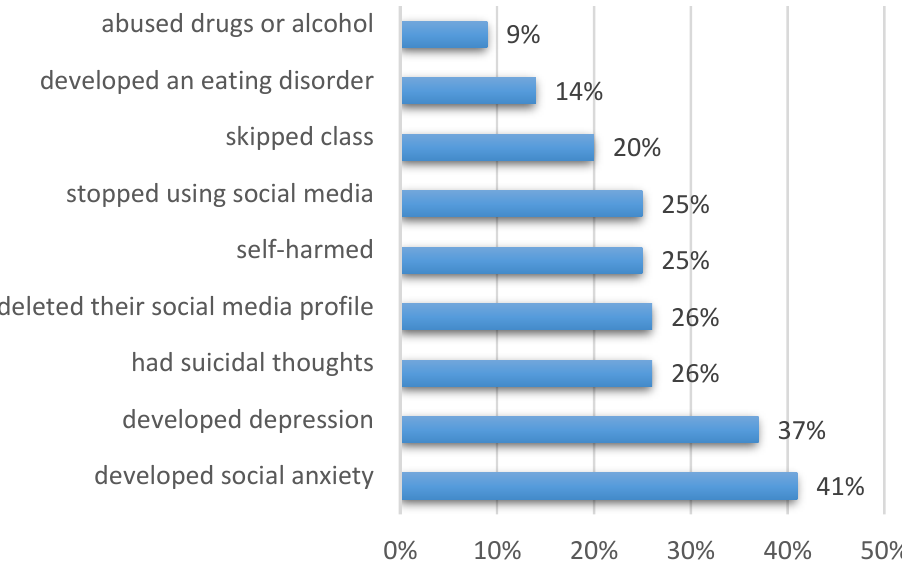
Figure 1. Examples of negative effects of cyberbullying.